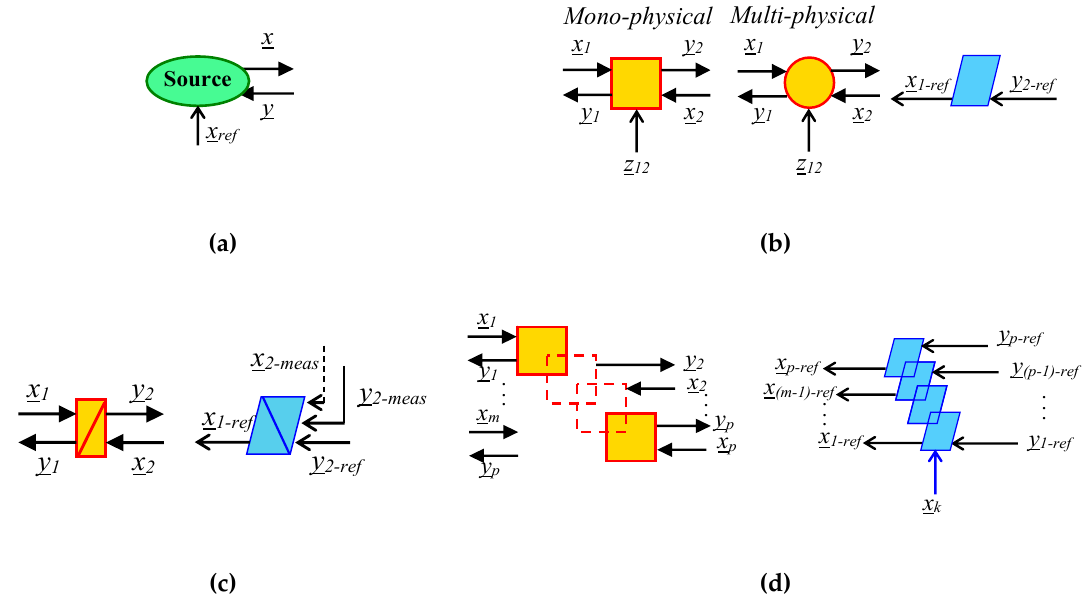
Figure 2. EMR elements. ( a ) Source element; ( b ) Conversion element; ( c ) Accumulation element; ( d ) Coupling element.